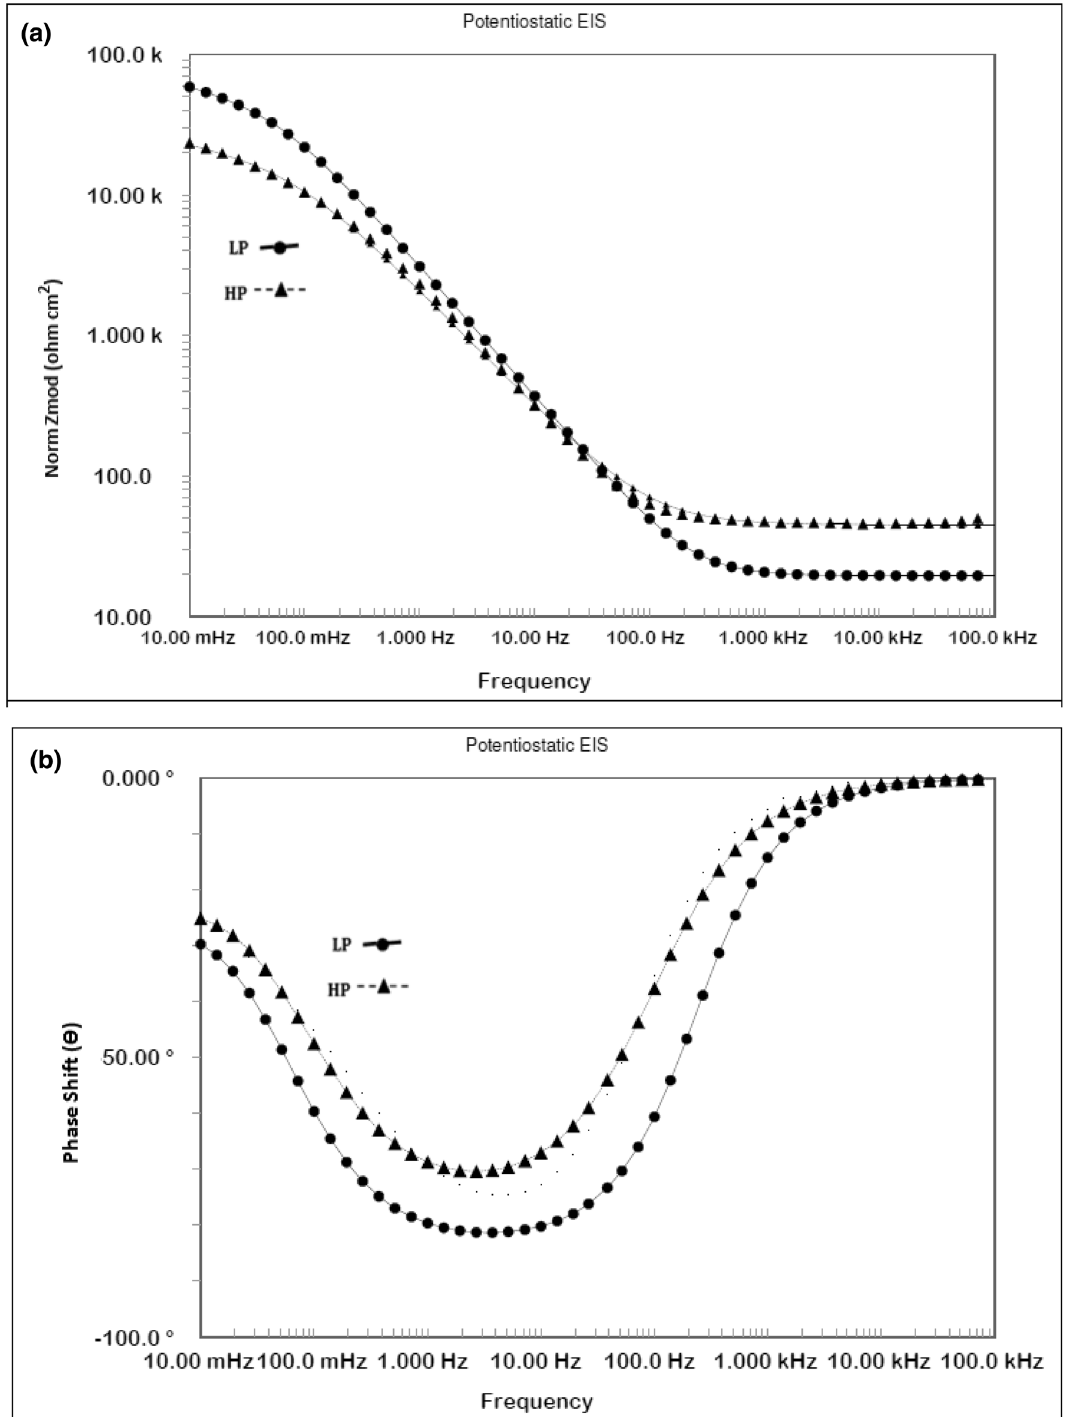
Figure 13. ( a ) Electrochemical frequency–impedance Bode plots for HP and LP steel bars after 192 h of their exposure in chloride added SPSL. ( b ) Electrochemical frequency–phase shift Bode plots for HP and LP steel bars after 192 h of their exposure in chloride added